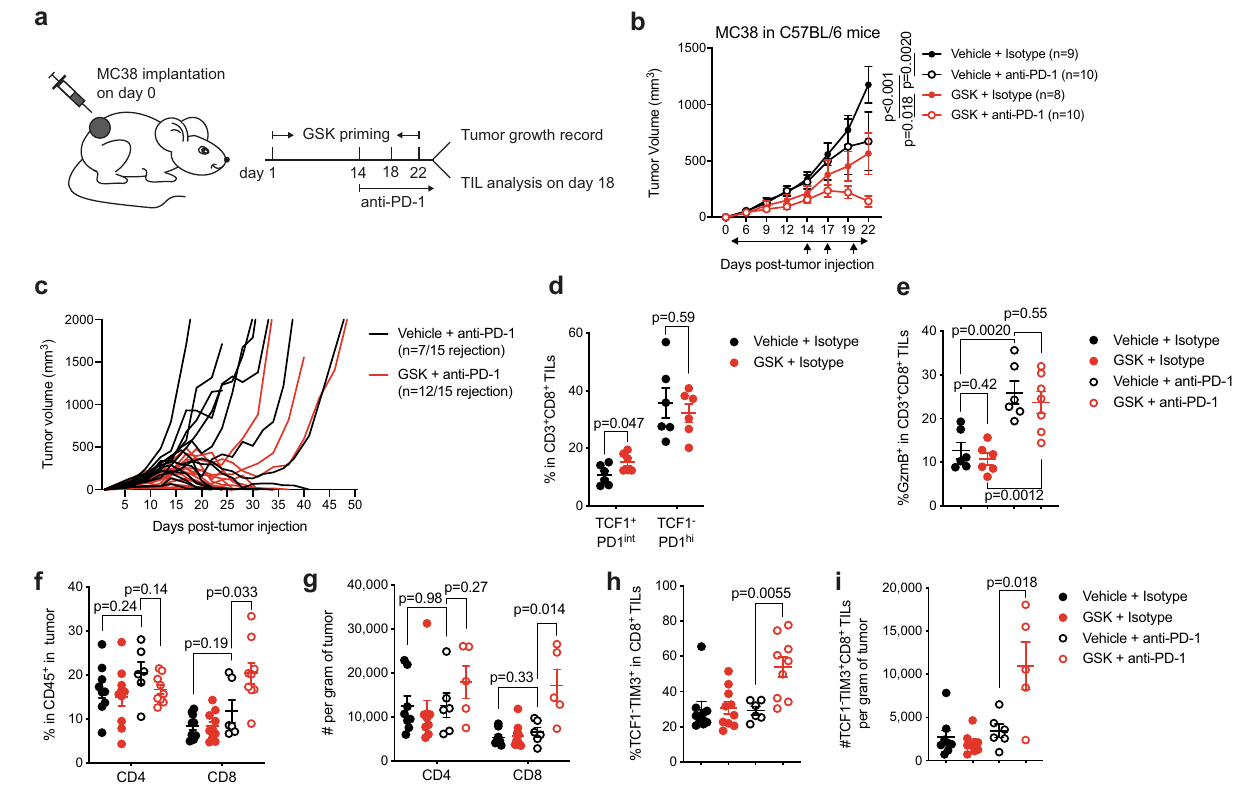
Fig. 7 Targeting LSD1 enhances long-lasting response to anti-PD-1 treatment. a Experimental design of administering GSK2879552 and PD-1 blocking antibodies. b Tumor growth curves of wildtype mice inoculated with MC38 tumor cells and treated with GSK2879552 or vehicle control in combination with anti-PD-1 or isotype control. c Individual tumor growth curves over time in response to anti-PD1 treatment alone or in combination with GSK2879552. d , e Percentages of TCF1 + PD-1 int and TCF1 - PD-1 hi cells ( d ) or GzmB + cells ( e ) in CD8 + TILs (Vehicle + Isotype, n = 6; GSK + Isotype, n = 6; Vehicle + anti-PD-1, n = 6; GSK + anti-PD-1, n = 7). f , g , Percentages ( f , n = 9, 10, 6, 9, respectively) and cell numbers ( g , n = 8, 9, 6, 5, respectively) of tumor-in fi ltrating CD3 + CD4 + T cells and CD3 + CD8 + T cells in gated CD45 + leukocytes. h , i Frequencies ( h , n = 9, 10, 6, 9, respectively) and cell numbers ( i , n = 8, 9, 6, 5, respectively) of CD8 + TCF1 - TIM-3 + TILs. Data represent two independent experiments ( b , d – i ) or are pooled from two